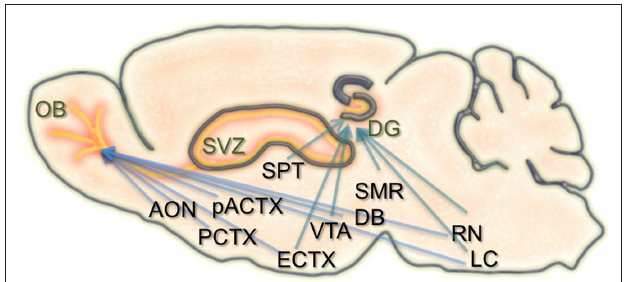
Figure 1 | Schematic of the inputs to regions of adult neurogenesis and circuit formation. Illustration of a sagittal section through the rodent brain. Orange areas depict regions of adult neurogenesis and circuit development. Blue arrows extending to the olfactory bulb (OB), and dentate gyrus (DG) originate from brain structures that have inputs to these areas. Many of these structures have inputs to both the OB and DG. SVZ, subventricular zone; AON, anterior olfactory nucleus; PCTX, piriform cortex; pACTX, periamygdaloid cortex; SPT, septum; ECTX, entorhinal cortex; VTA, ventral tegmental area; DB, nucleus of the diagonal band; SMR, supramammillary region; RN, raphe nucleus; LC, locus